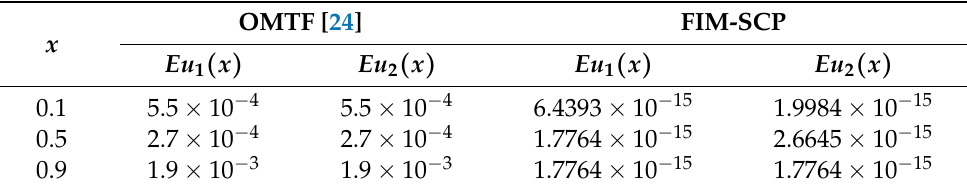
Table 1. Absolute errors of u 1 ( x ) and u 2 ( x ) when α 1 = α 2 = 1 for Example 1.